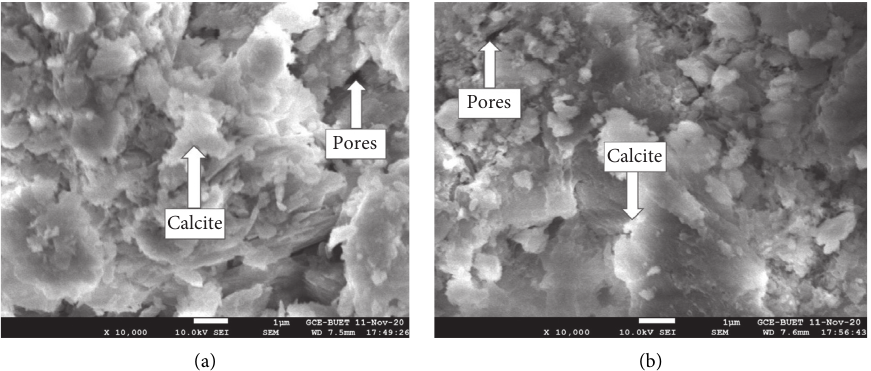
Figure 9: SEM imaging of E coli-induced concrete. (a) 25MPa microbial concrete. (b) 35MPa microbial concrete.